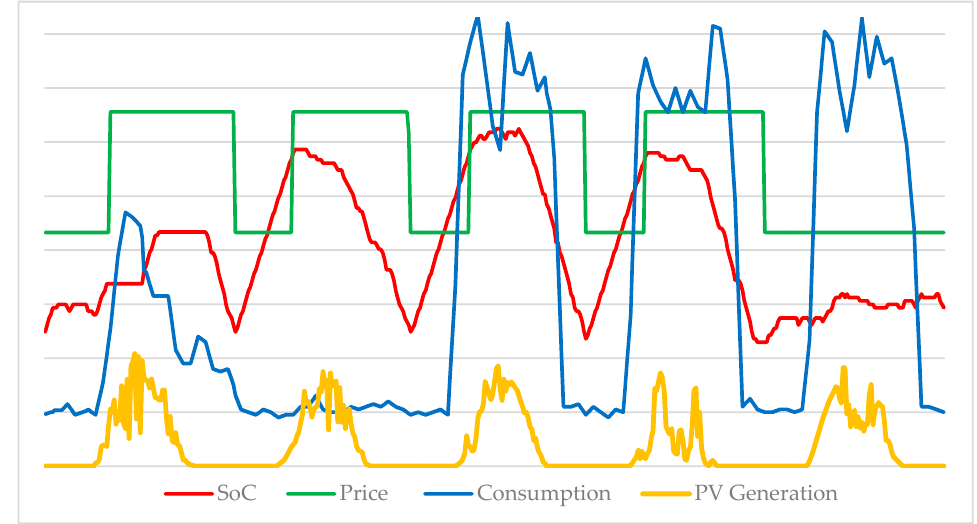
Figure 8. The operation of the BESS (price is dominant). The decision-making and optimisation algorithm follows the price signal, charges the battery when the price is low and discharges when the price is high.